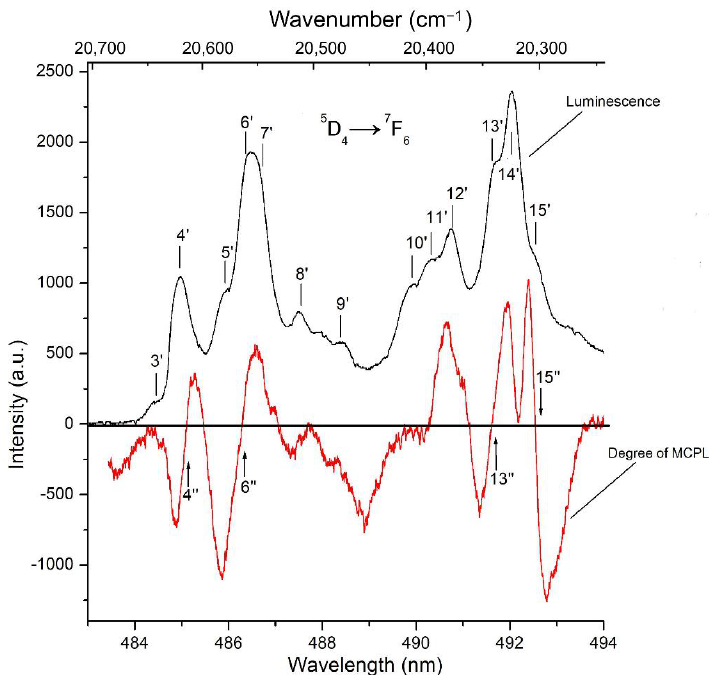
Figure 7. The spectra of the degree of MCPL (red solid) and PL (black line) of the KTF crystal at a temperature of T = 90 K in the visible spectral region. The MCPL spectrum is recorded in a magnetic field H = 5 kOe. The characteristic features of the spectra are numbered in accordance with the transitions scheme shown in Figure